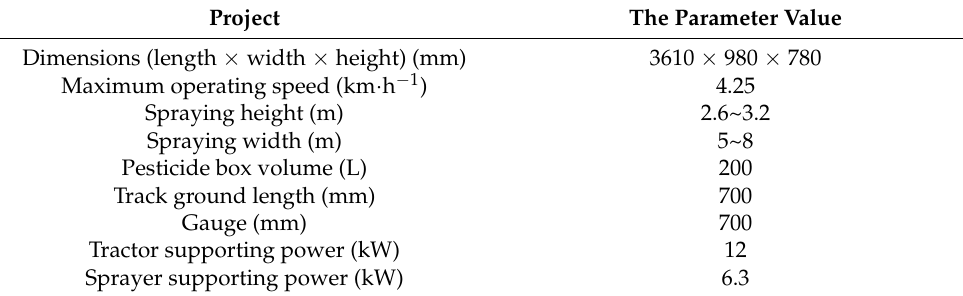
Figure 1. Orchard traction spraying robot. Table 1. The main technical parameters of the orchard traction spraying robot.